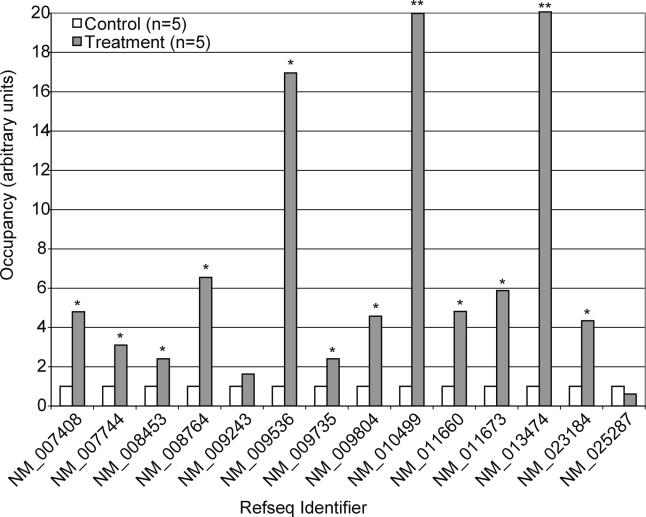
Quantitative PCR Confirms GR Targets Identified by Location AnalysisThe enrichment of GR targets identified by location analysis was measured in the original immunoprecipitated material by QPCR. The graph shows the fold-enrichment of five dexamethasone-treated samples compared to five fed controls. Of fourteen randomly selected GR targets, 12 showed statistically significant enrichment. Fold-enrichment and p-values were calculated as described in Materials and Methods. *p < 0.05, **p < 0.01.